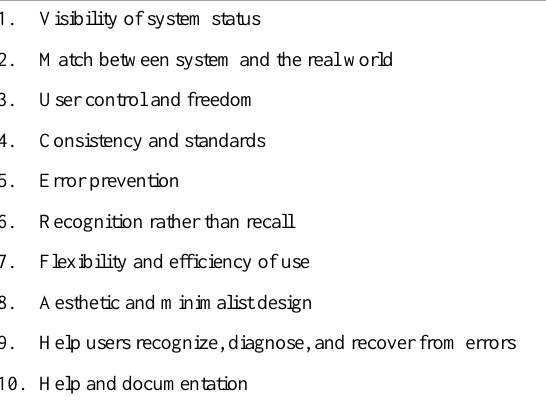
Textbox 1. The 10 Nielsen usability